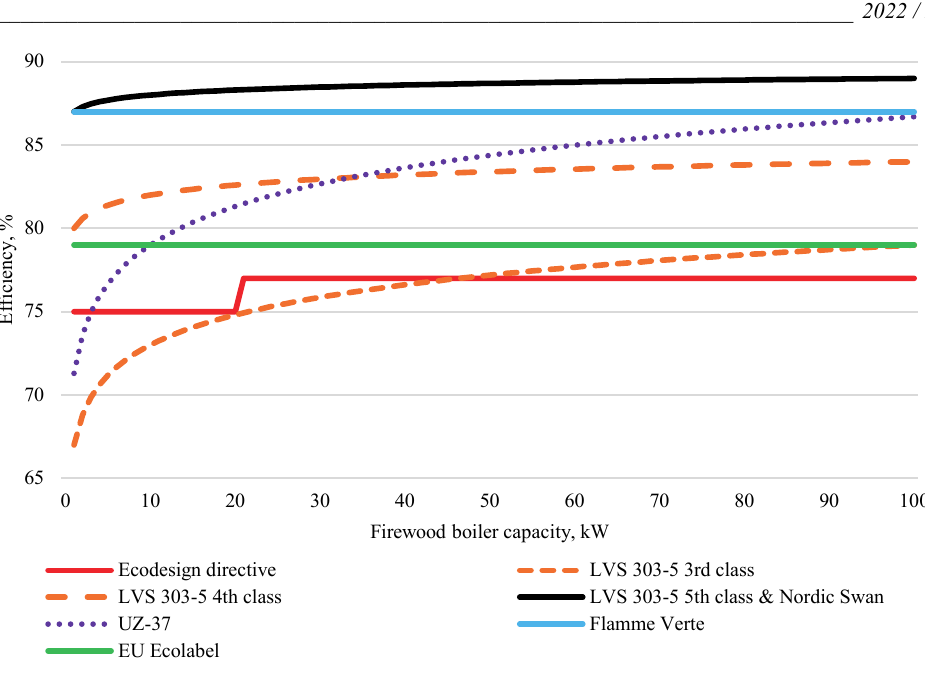
Fig. 3. Defined requirements regarding the efficiency of firewood